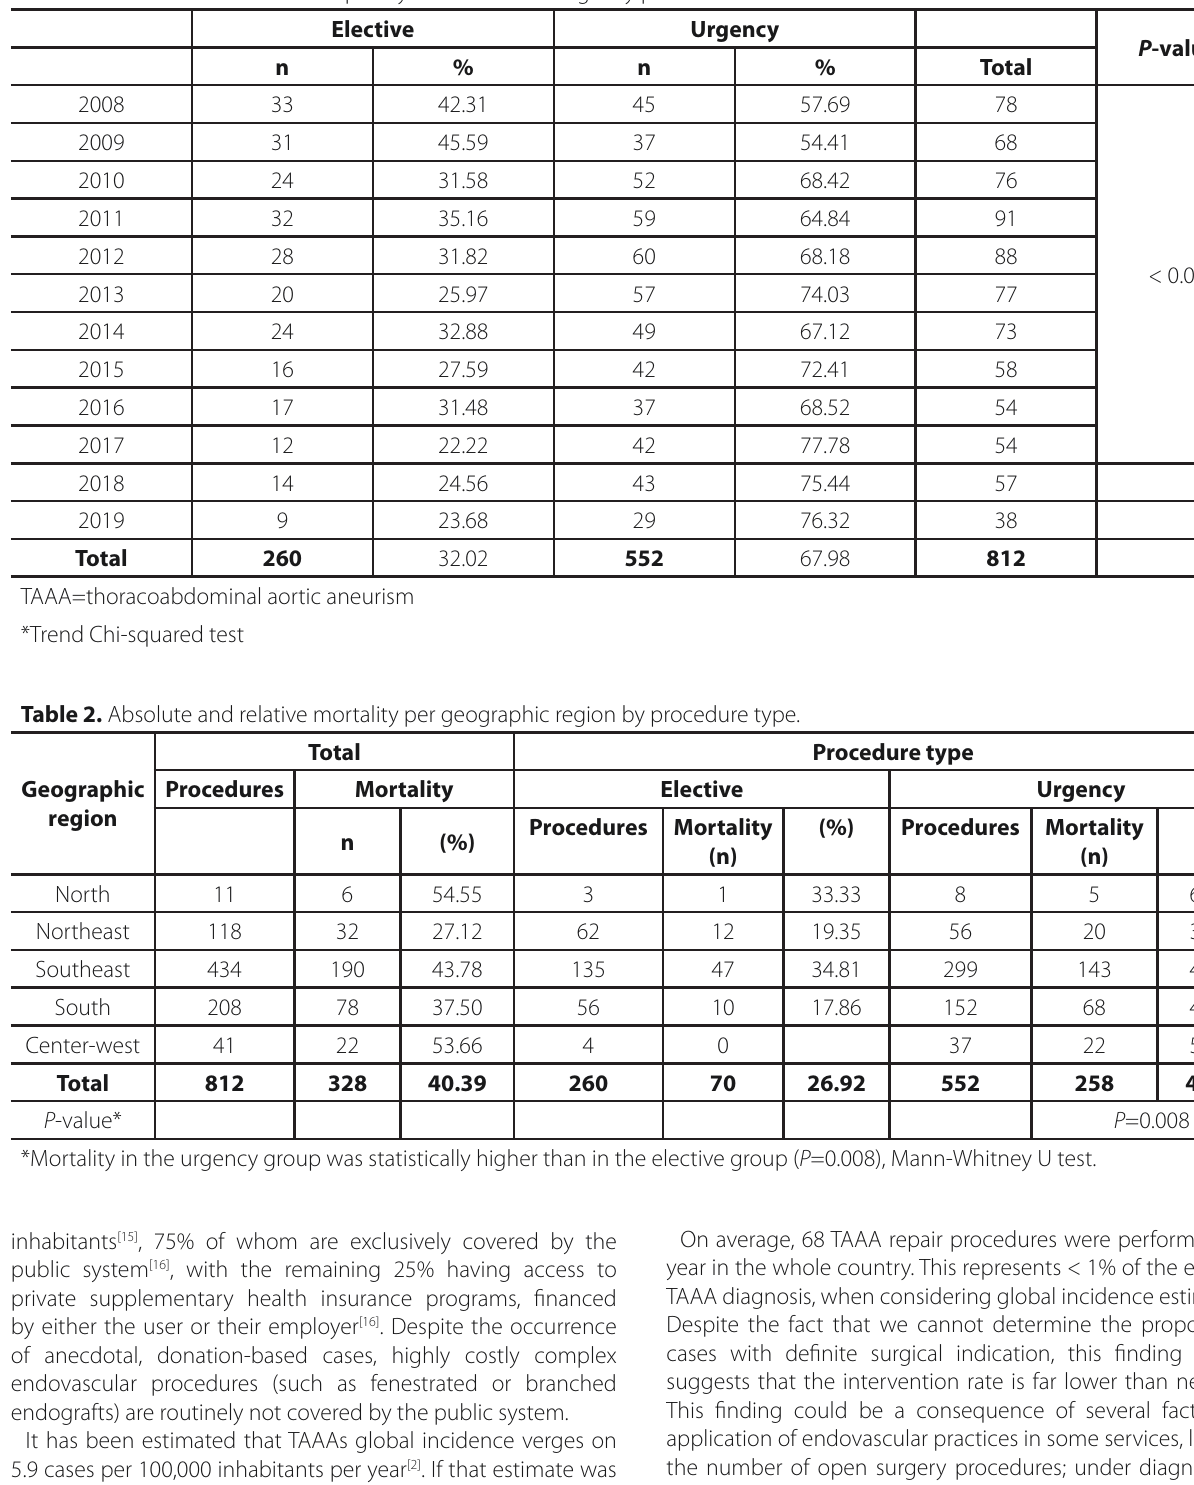
Table 1. Absolute and relative frequency of elective and urgency procedures for TAAA between 2008 and 2019.